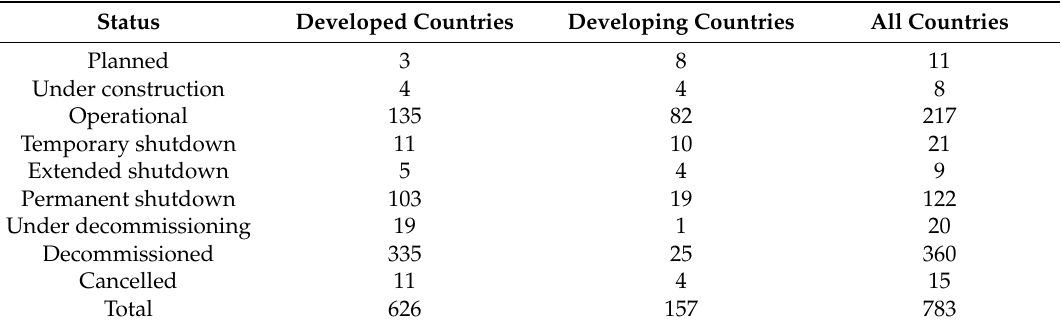
Table 2. Overview about all research reactors with their status (2017).